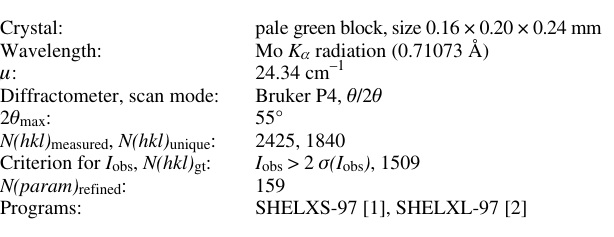
Table 1. Data collection and handling.